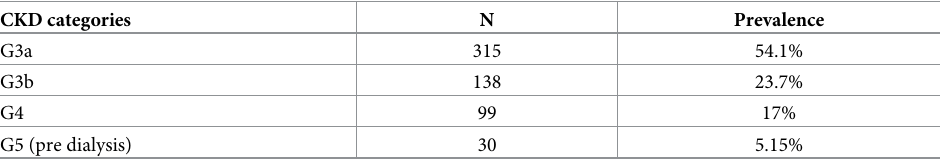
Table 2. CKD patients classified according to eGFR